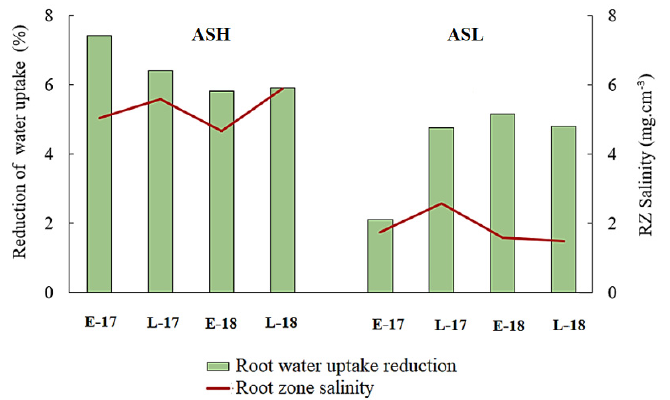
Figure 12. Simulated root zone salinities and corresponding reductions in tree water uptake at the ASH site (west SJV) and the ASL site (east SJV). “E” refers to the early growing season (February– March period), and “L” refers to the late growing season (July–August period).